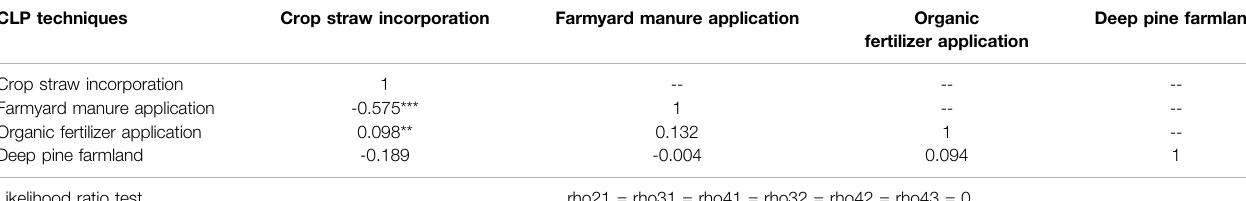
TABLE 4 | Results of the multivariate probit regression covariance matrix. CLP